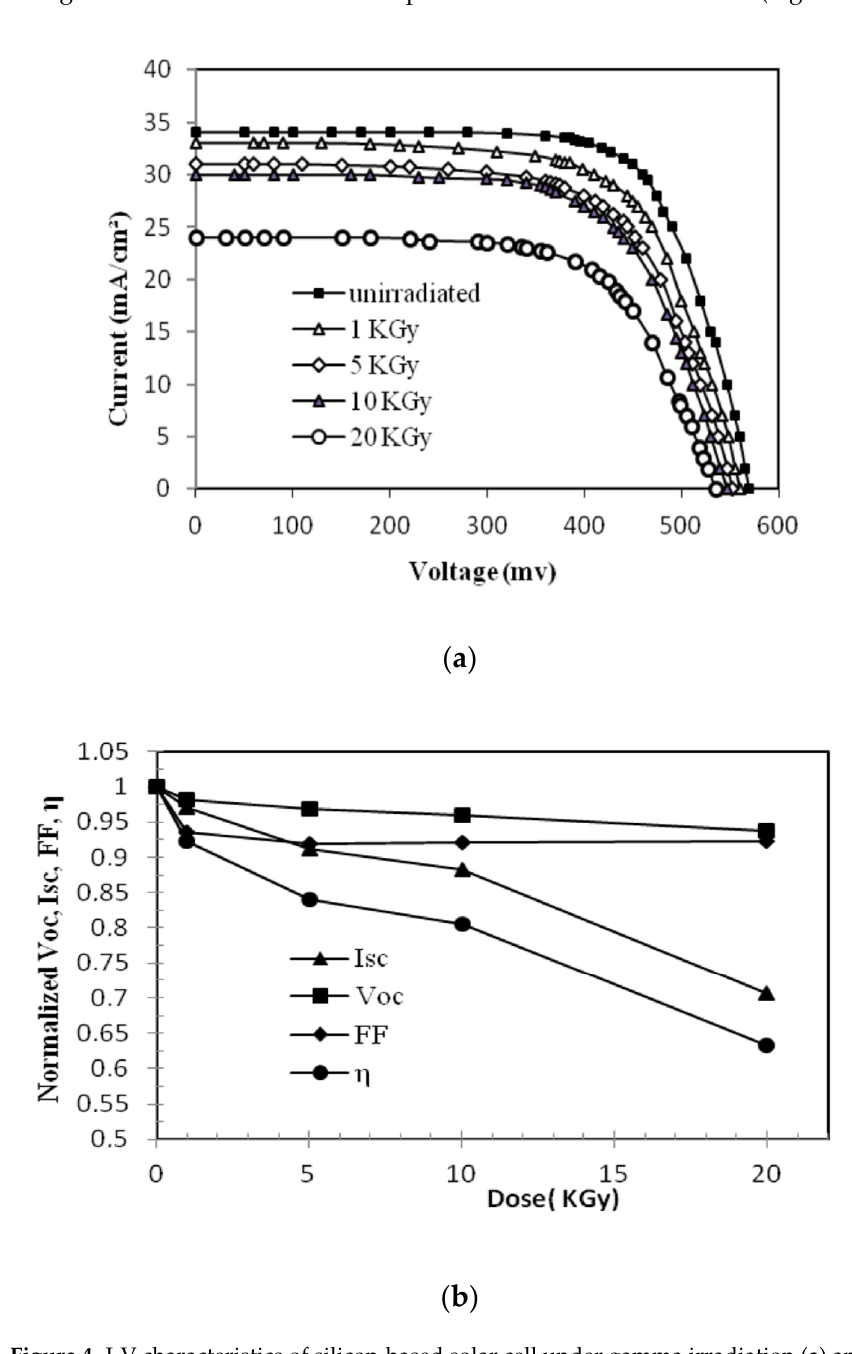
Figure 4. I ‐ V characteristics of silicon ‐ based solar cell under gamma irradiation ( a ) and normalized PV parameters as a function of gamma irradiation dose ( b ). Reproduced with permission from [113].